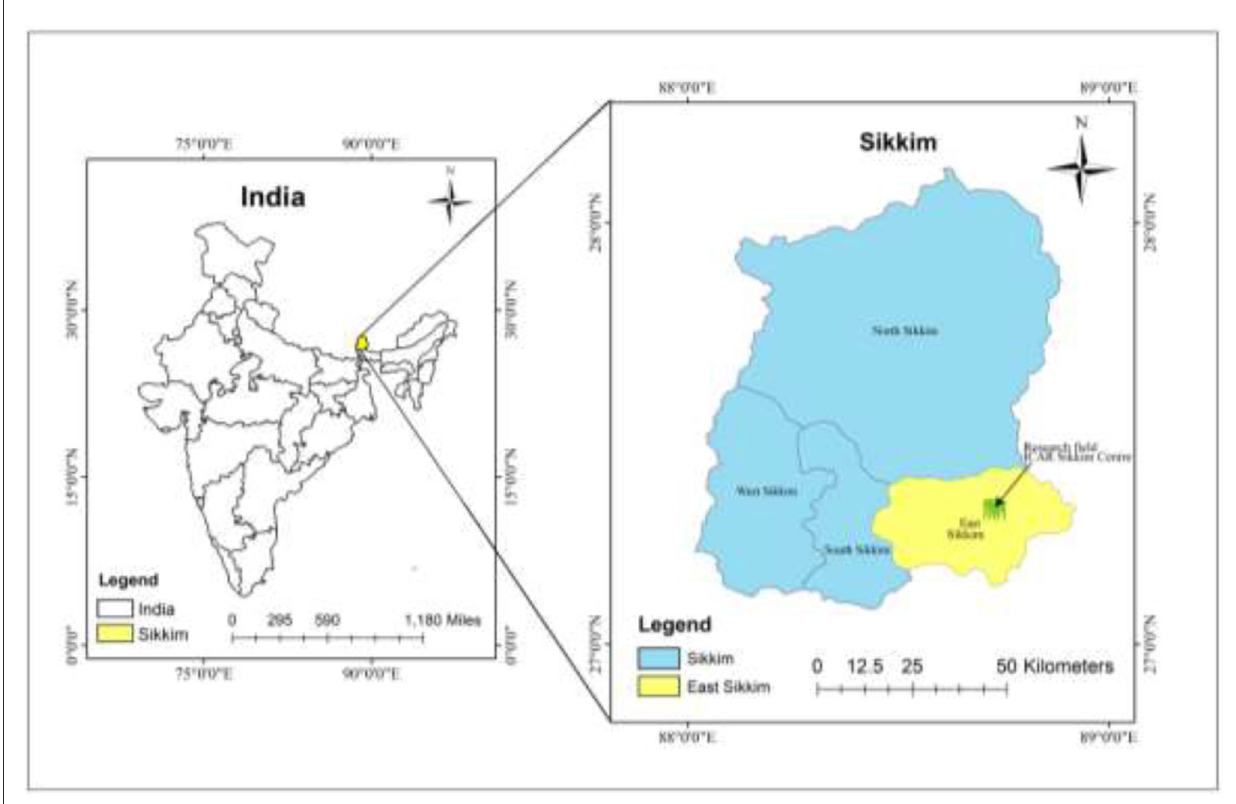
FIGURE1 A map showing the study site in the Indian Himalayan region (IHR).